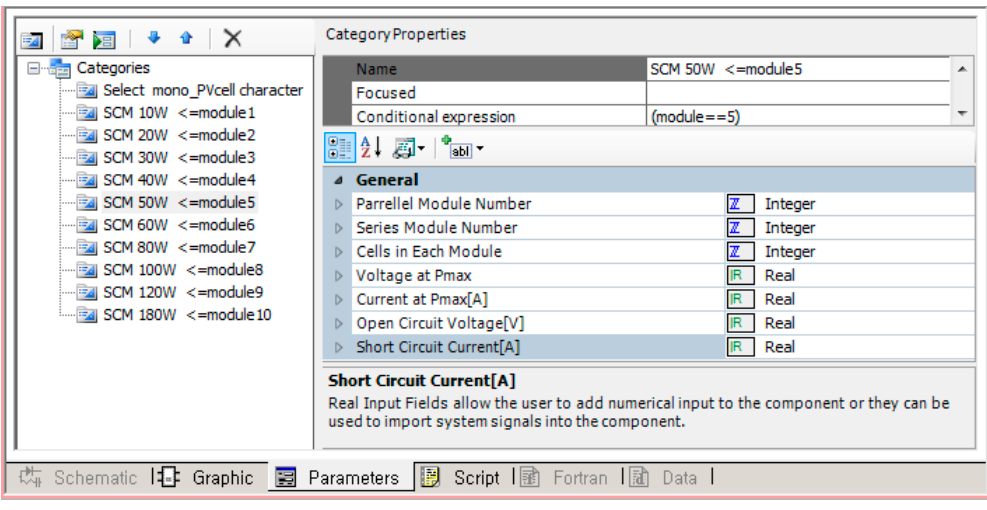
Figure 3. Creation of PV array parameter input window.